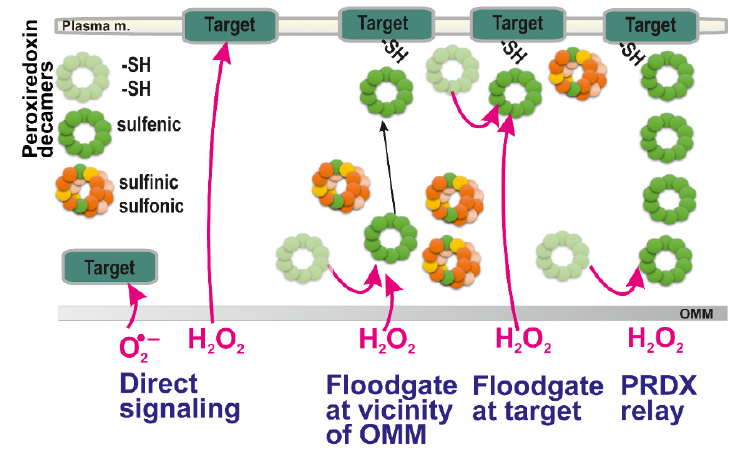
Figure 2. Possible ways of redox signal spreading — from left to right: ( i ) direct superoxide diffusion; ( ii ) direct H 2 O 2 diffusion; ( iii ) peroxiredoxin-mediated redox signal transfer including diffusion of peroxiredoxin decamers; ( iv ) combination of ( ii ) and ( iii ), i.e., H 2 O 2 diffusion followed by the peroxiredoxin relay (peroxiredoxin “redox kiss”); and ( v ) hypothetical redox relay via an array of peroxiredoxins. Note, that according to a flood-gate model, H 2 O 2 oxidizes PRDX to higher states than a sulfenic state ( green ; basic reduced state light green ), such as sulfinic ( yellow ) and irreversible sulfonic state ( orange ). This allows only distant decamers in a sulfenic state either to migrate to the target ( iii ) or to oxidize target at its vicinity ( iv ). The hypothetical mechanism ( v ) should still be verified experimentally.